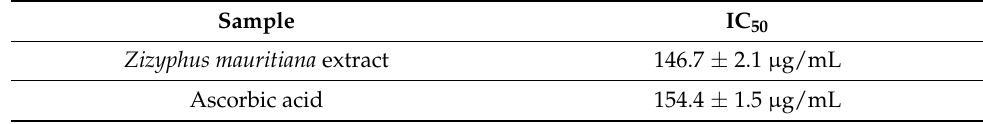
Table 2. Superoxide radical scavenging activity of Z. mauritiana fruit extracts.